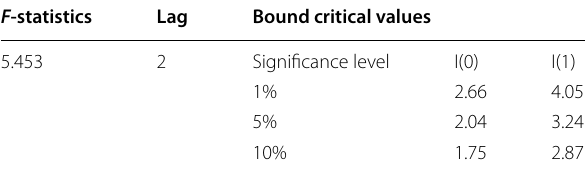
Table 3 Bounds test results